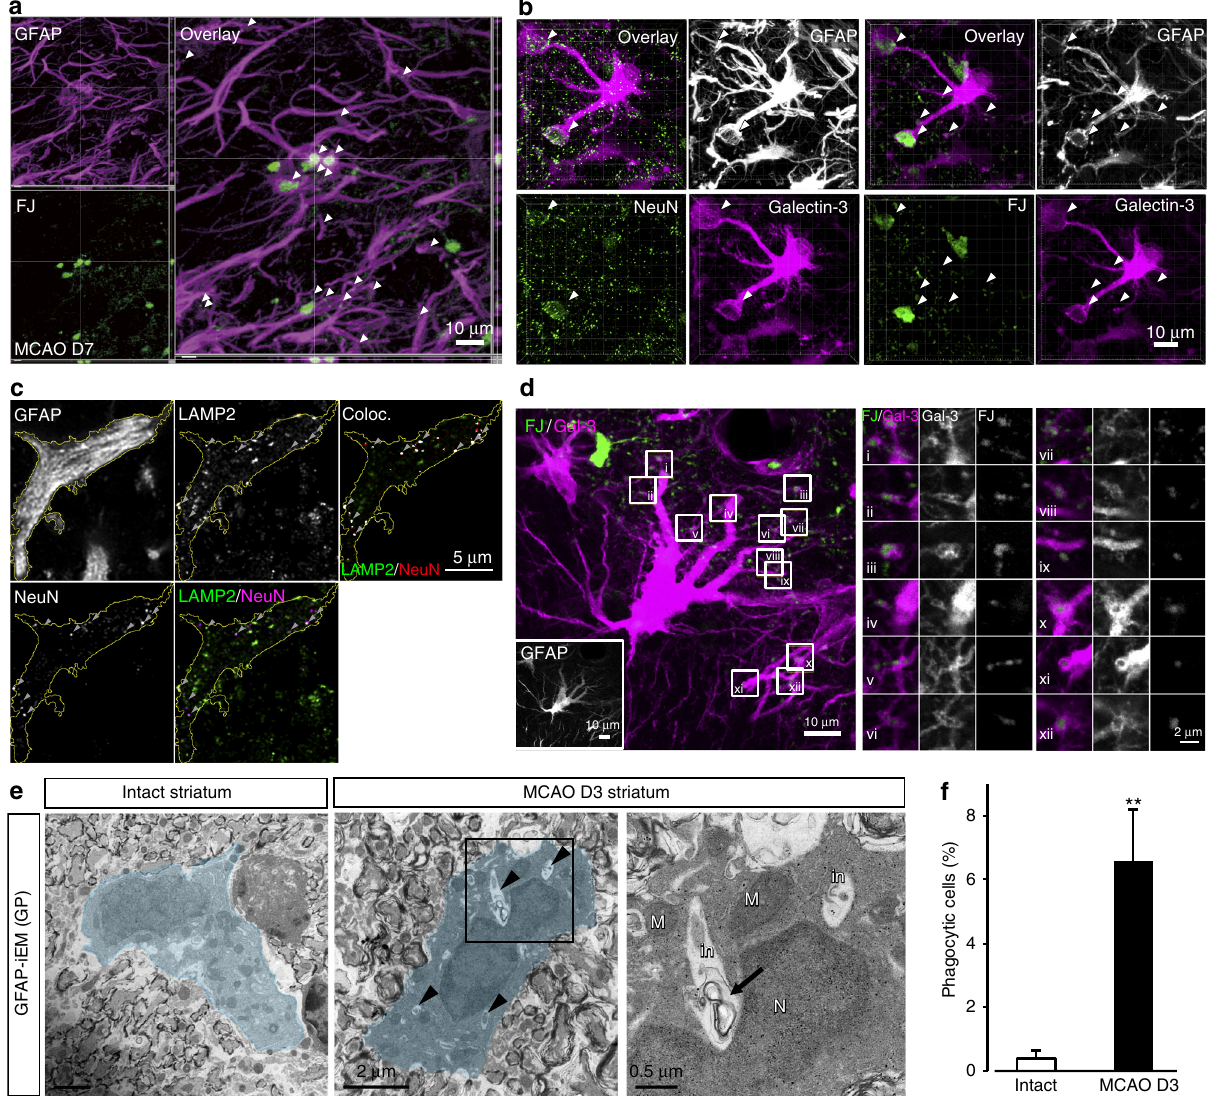
Fig. 1 Astrocytes become phagocytic after transient ischemic injury in vivo. a Representative images of the ischemic penumbra showing FJ-labeled and GFAP-immunostained brain sections at 7 days after MCAO ( n = 10 mice). Arrowheads indicate FJ + -degenerating neuronal debris enwrapped by GFAP + astrocytes. Fourteen images per z-stack image (0.49 µ m step). b Representative image of GFAP + , Galectin-3 + astrocyte enwrapped NeuN + , FJ + large neuronal debris. Arrowheads indicate FJ + degenerating neuronal debris enwrapped by GFAP + astrocytes. Thirty-four images per z-stack image (0.3 µ m step). c Representative images of NeuN + signals in LAMP2 + lysosomes in GFAP + astrocytes ( arrowheads ). d Processes of Galectin-3 and GFAP double-positive astrocytes enwrapping numerous FJ + small debris ( n = 8 mice). The white squares in the left panel image indicate the region of high magni fi cation of shown in the right panel. e Immunoelectron microscopic (iEM) images of GFAP + astrocytes (gold particles: GP; blue ). Left , an image of an astrocyte in the striatum of an intact mouse. Middle , an image of an astrocyte in the ipsilateral striatum at 3 days after MCAO. Arrowheads indicate phagocytic inclusions. Right , high-magni fi cation image of the box shown in the middle panel . Arrow indicates myelin-like structure. N, nucleus; M, mitochondria; in, phagocytic inclusion. f Percentage of GFAP + astrocytes with phagocytic inclusions in total in the intact ( n = 461 cells, 4 mice) and MCAO-treated striatum ( n = 315 cells, 4 mice, ** P = 0.0056, unpaired t -test). Values represent means ±